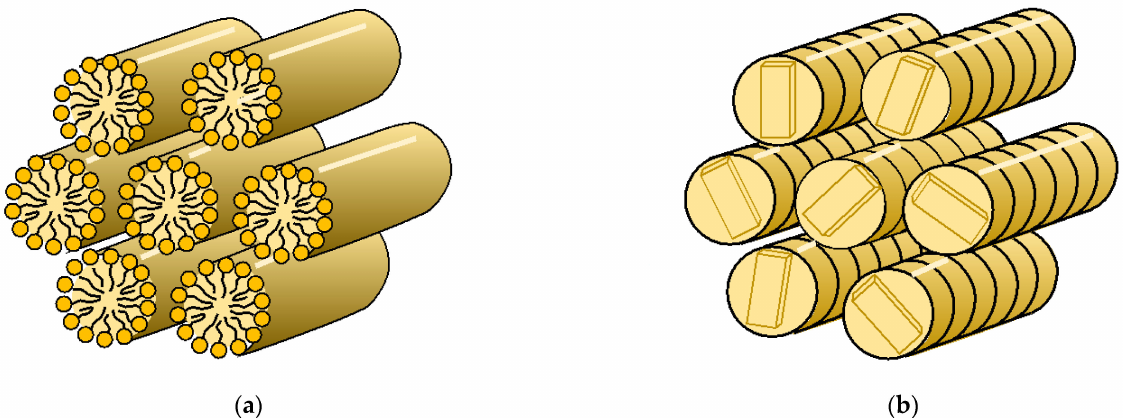
Figure 3. Stylized representations of hexagonal columnar phases. ( a ) The M1 middle phase of an amphiphile/water system, showing a hexagonal array of cylindrical micelles in an aqueous continuum. The wavy radial lines represent more-or-less fluid aliphatic chains, and the small peripheral circles around each cylinder represent the hydrophilic head groups, with ionic or hydrogen bonding properties. ( b ) The hexagonal columnar structure of the chromonic M phase, showing the stacked aromatic molecules held face-to-face by π – π interactions. The rectangles drawn on the face of the discs indicate the random orientation of the stacks of aromatic groups in the